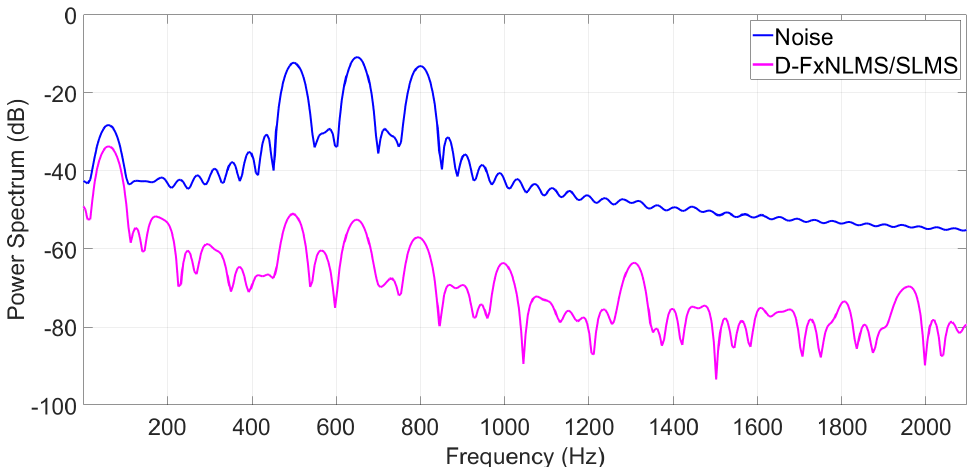
Figure 11. Power spectrum of the error signal at observation microphone by taking into account a multi–tone as a reference